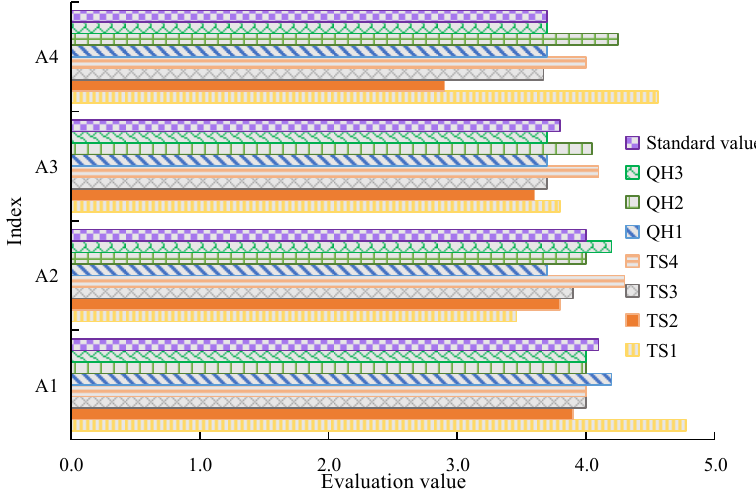
Figure 7. Participants’ Feelings of Seven Projects of the Kailuan System. Figure 8a,b refer to the design of Qinhuangdao Electric Power Museum and Kailuan National Park, respectively. It can be seen from Figure 8a that the structure is brick-red when viewed from a distance, and the brick joints are grayish white when it is close to the building. The texture sense is strong, and there is not too much decoration and